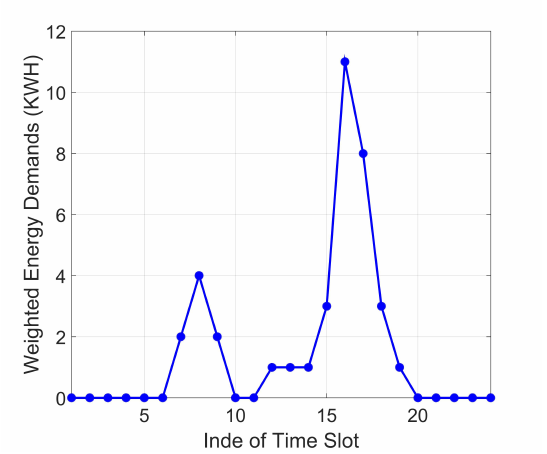
Figure 4. The accumulated weighted energy demand for 24 time slots by analyzing 246 days data. The x -axis is index of time slot. The y -axis is weighted energy demand with unit of kWh.